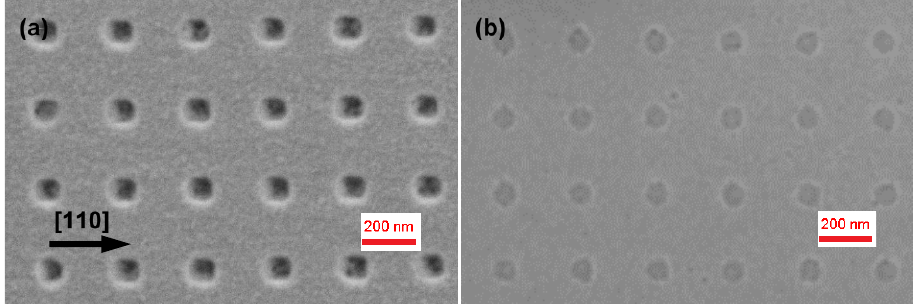
Figure 3. SEM images of a patterned GaAs surface after in situ oxide removal by ( a ) Ga-assisted deoxidation; ( b ) In-assisted deoxidation. deoxidation; ( b ) In-assisted